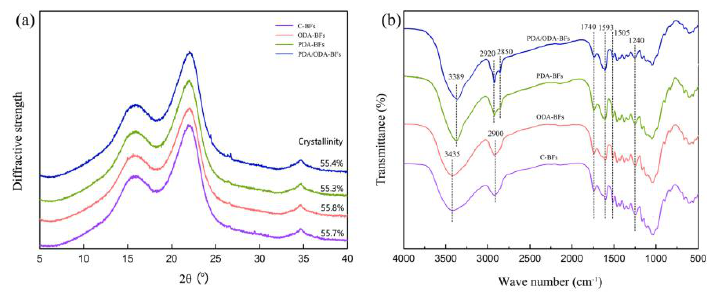
Figure 2. XRD patterns ( a ); and FTIR spectrum ( b ) for the C–BFs, ODA–BFs, PDA–BFs, and PDA/ODA–BFs samples.